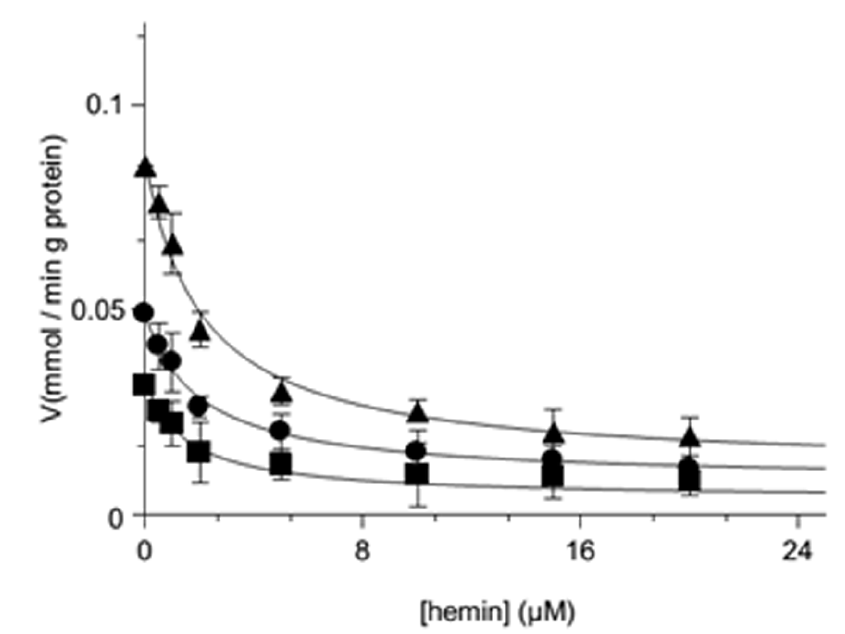
Figure 2. Inhibition of the transport activity of [ 14 C] malate on the reconstituted OGC by external hemin. The transport rate of [ 14 C] malate was measured in 2 min in the absence or in the presence of increasing concentrations of external hemin (0.5–20 μM). [ 14 C] Malate was added along with hemin at a concentration of 0.025 mM ( , R 2 = 0.978), 0.05 mM ( ●, R 2 = 0.993), or 0.1 mM ( ▲, R 2 = 0.987 ) to proteoliposomes containing 6 mM of 2-oxoglutarate. The values presented are the means ± SD of three independent experiments.